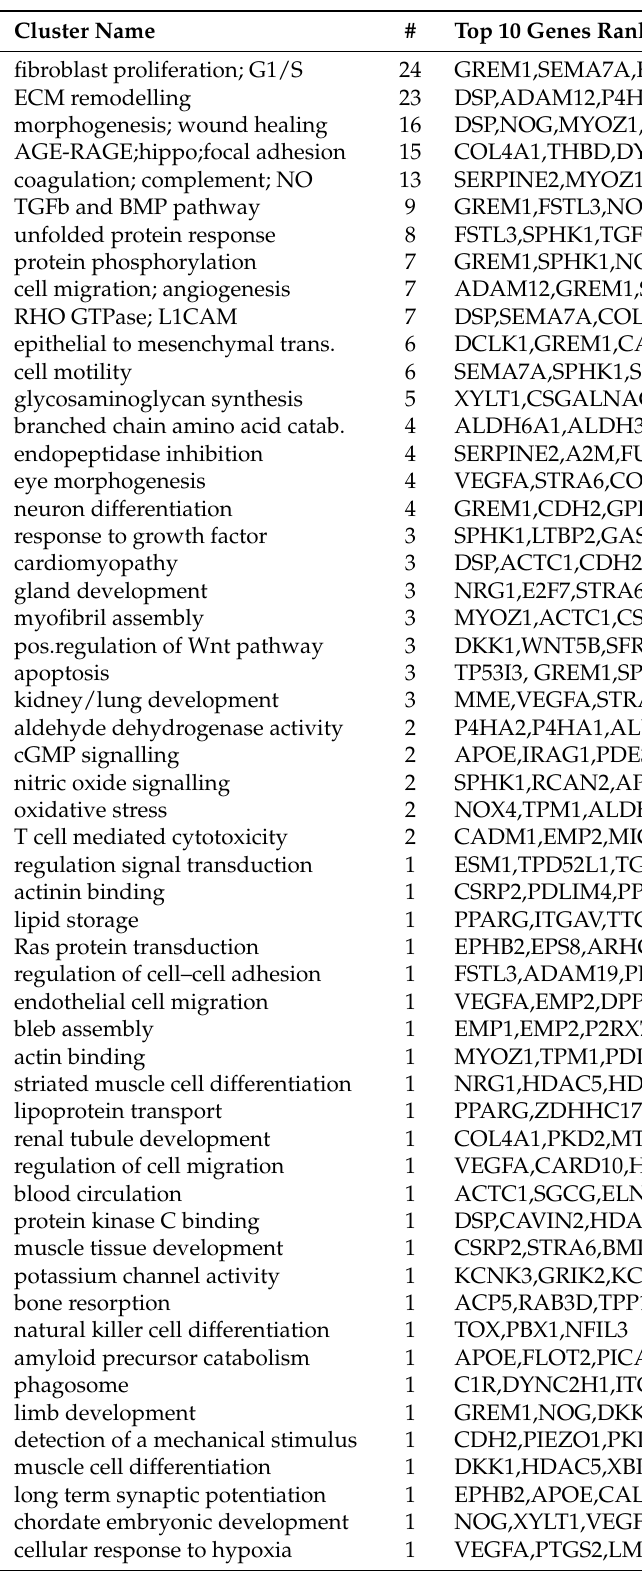
Table 3. Enrichment clusters after clustering of enrichment terms. Shown is the cluster name, number of enrichment terms within the cluster (column #) and top 10 genes ranked by